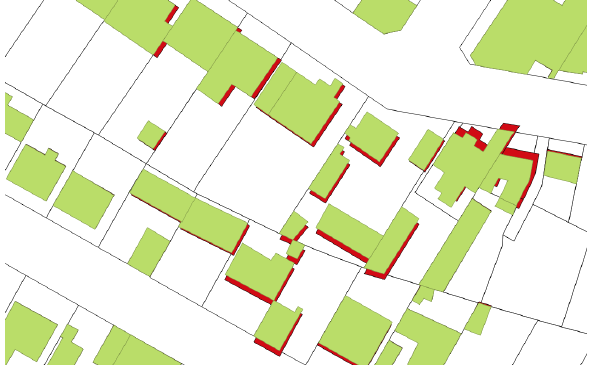
Figure 7: Original data set (red) and corrected data set (green).